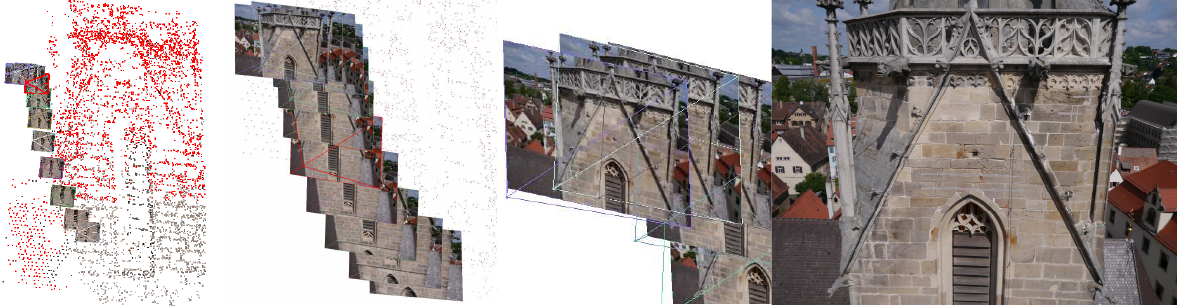
Fig. 4.1: Rottenburg dataset. 11 images with 16 Megapixels each distributed closely to each other.